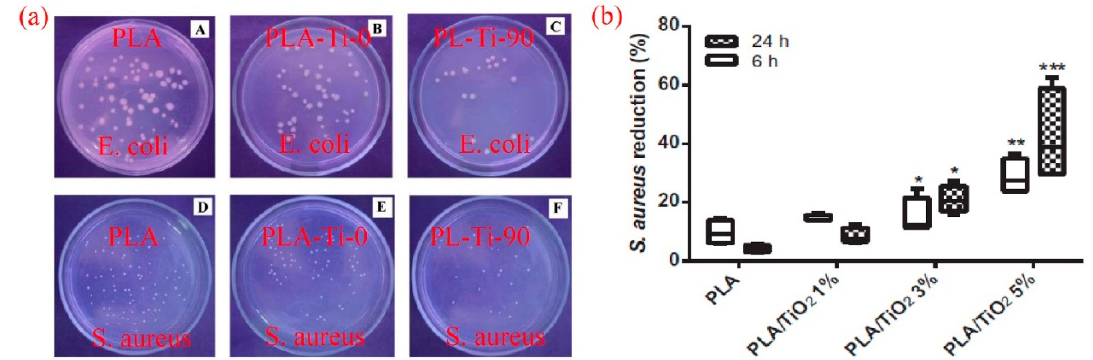
Figure 7. ( a ) Antimicrobial activity of PLA PLA / TiO 2 composites against E. coli and S. aureus [56], ( b ) S. aureus reduction as a function of TiO 2 content